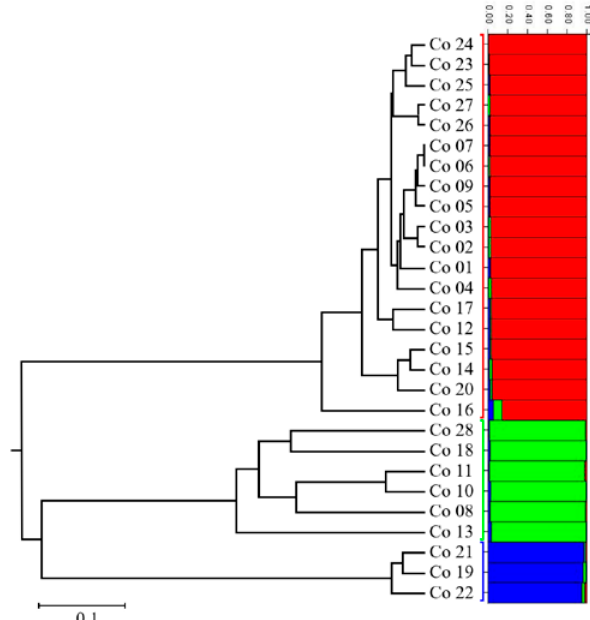
Figure 3. UPGMA tree based on the ISSR and iPBS combined marker data for 28 isolates, and STRUCTURE bar plots for individ- ual assignment results for K = 3.